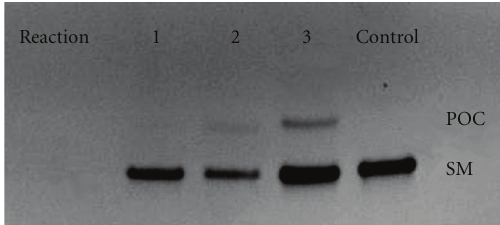
Figure 2: PAGE analysis of reactions 1–3 from Table 1. The coupling reagents used in lanes 1, 2, and 3 are HBTU, PyBOP, and DMTMM, respectively. As demonstrated by the control lane, starting material (SM) is below the slower-moving peptide- oligonucleotide conjugate